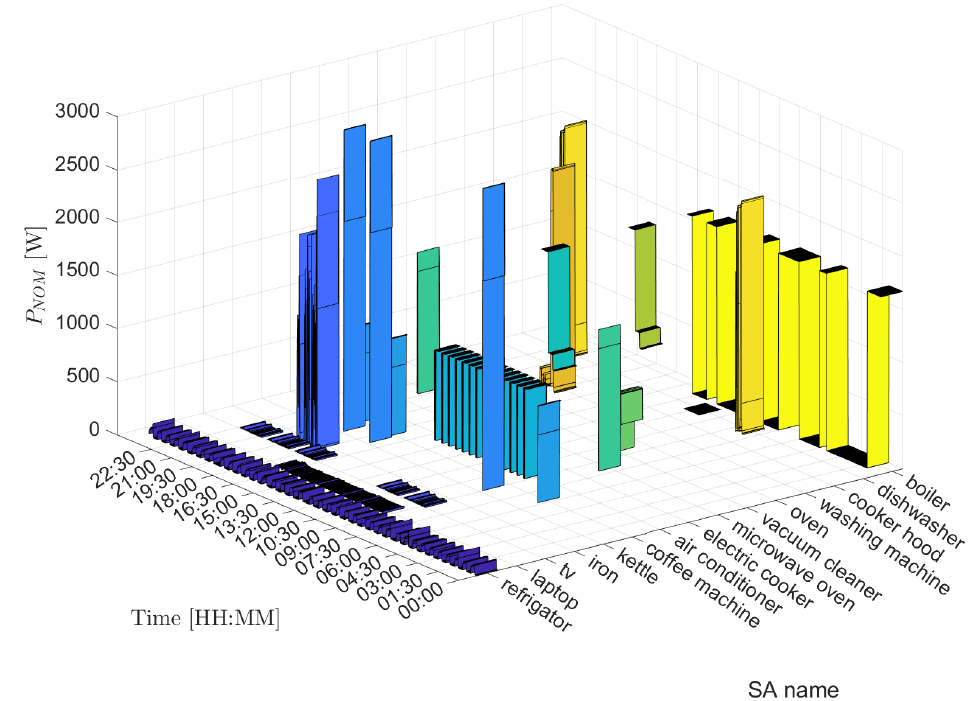
Figure 4. Schedule of the launch of individual